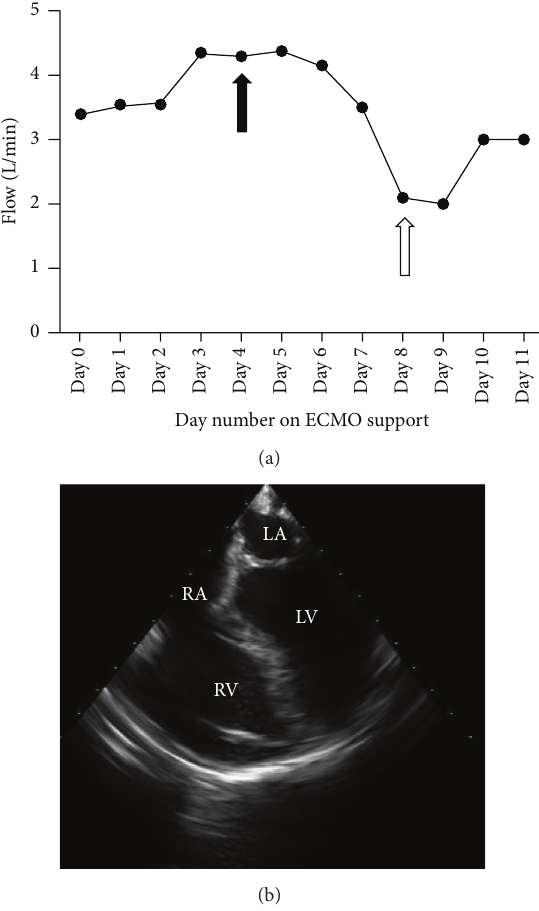
Figure 1: hTEE monitoring of VA-ECMO support. hTEE assess- ments were performed on day 4 (black arrow) and day 8 (white arrow), respectively (a). A mid-esophageal four-chamber view (day 11) revealed persistent biventricular systolic dysfunction despite VA- ECMO support